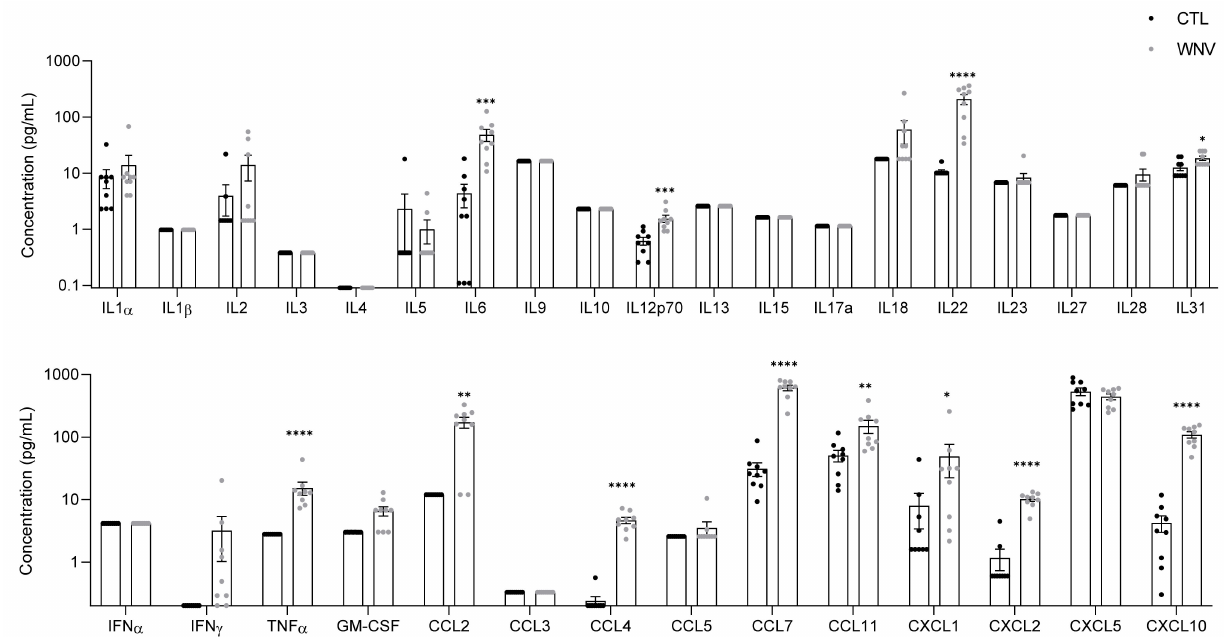
Figure 1. Upregulation of pro-inflammatory mediators after WNV infection in the serum of C57/BL6 mice (6 dpi). Plasma concentration in pg/mL of pro-inflammatory markers measured by multiplex bead-based ELISA in non-infected (black) and WNV-infected mice (grey). Bars show means ± SEM (* p < 0.05, ** p < 0.01, *** p < 0.001, **** p <